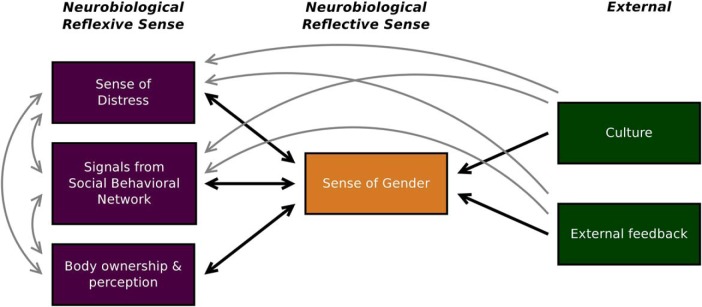
Diagram of the multisense theory of gender dysphoria. The overall sense of gender in an individual is modeled as a neurobiological, reflective sense, integrating information from multiple senses and stimuli (bold arrows). This sense of gender is framed relative to gender assigned at birth (e.g., am I the gender that was assigned at birth?) rather than an absolute male/female dichotomy (e.g., am I female?). Each of the three listed reflexive senses (purple boxes) relate to a specific dimension of diagnostic criteria for gender dysphoria as well as a matching functional network with nodes known to be altered in transgender individuals (Fig 1). The interaction between sense of gender and these three reflexive senses may be bidirectional. External factors (green boxes) influence sense of gender either directly (bold arrow) or indirectly via affecting the reflexive senses. The model can also be extended to include additional internal and external factors. The diagram represents a dynamic network, not a specific causal pathway, and includes potentially complex interactions and feedback loops.